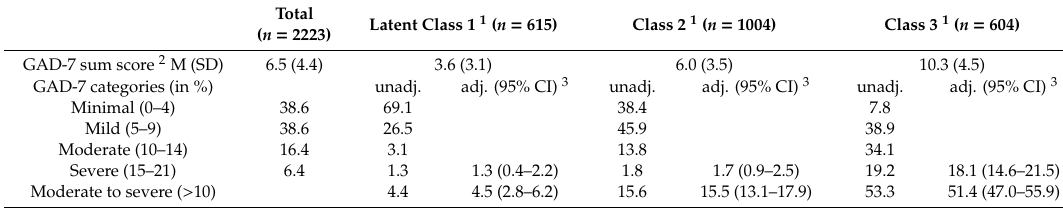
Table 2. Anxiety sum score and severity levels, unadjusted and adjusted proportions, by latent class ( n =